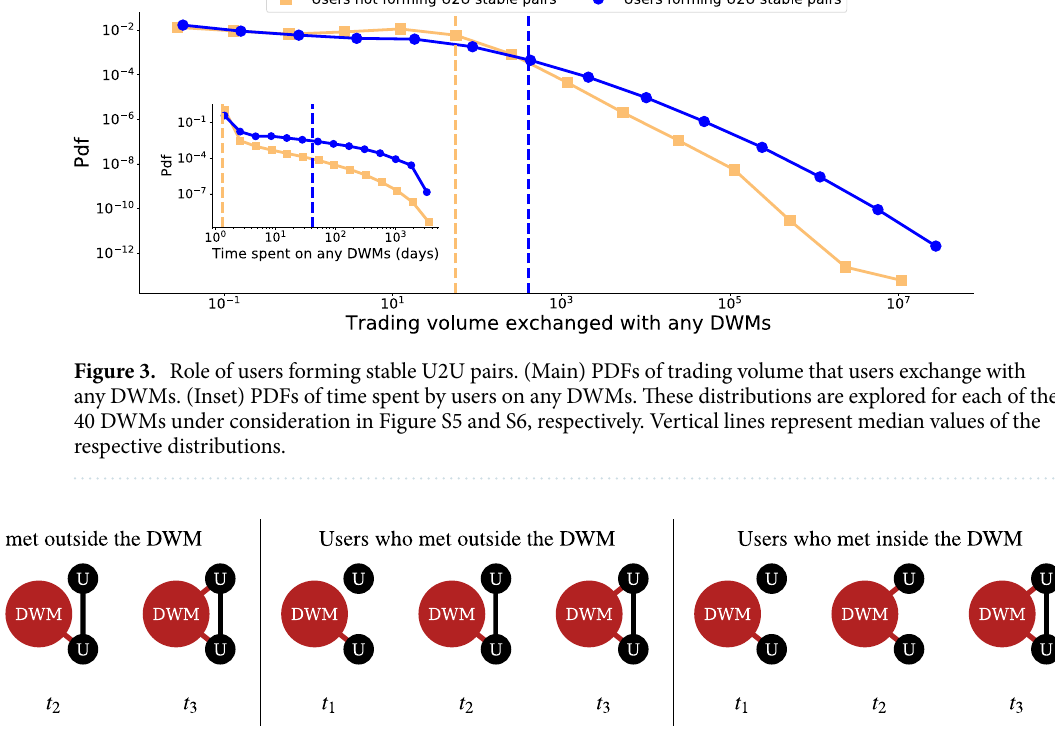
Table 1. Formation mechanism of stable U2U pairs. We compare the time at which the first transaction between a pair of users occurred with the time in which these users interacted with the same DWM. Each row in the figure indicates a possible temporal sequence, which we classify in two groups: users who met outside the DWM (first two columns) and users who met inside the DWM (last